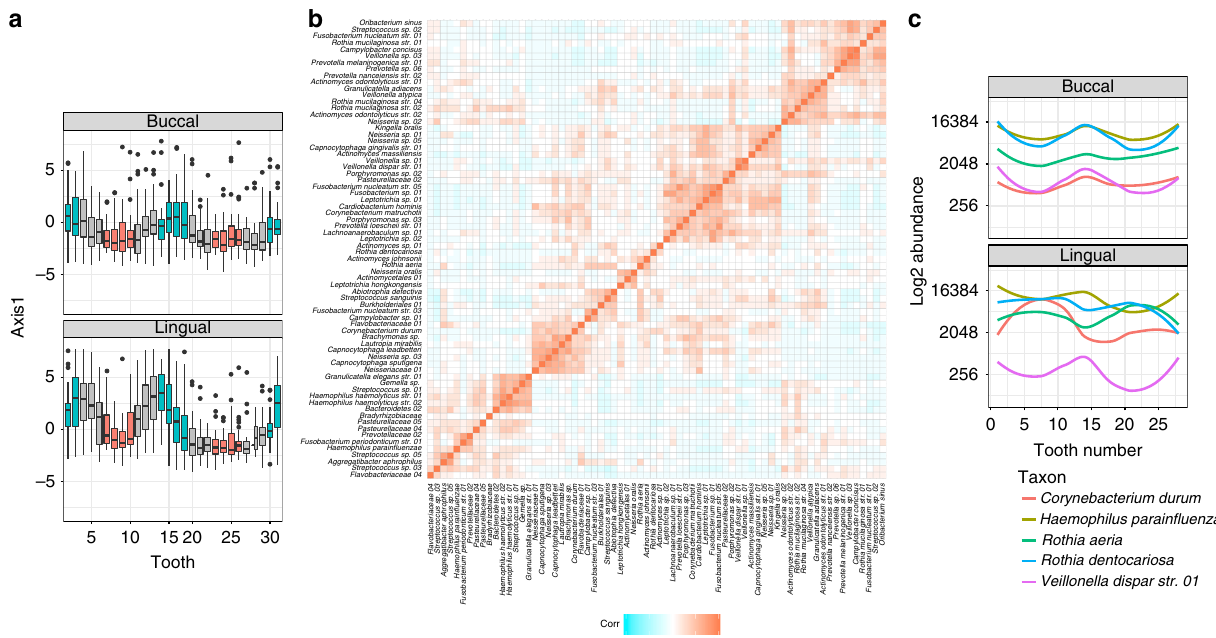
Fig. 2 Supragingival communities vary by tooth class in a structured fashion suggestive of a gradient. a Trend surface analysis (TSA) was performed on the species by sample data matrix (117 taxa, 1701 samples). TSA axis 1 scores ( y axis) are plotted as a function of universal tooth number ( x axis). Each box demarcates the fi rst and third quartiles of the TSA axis 1 scores, for each tooth, while the horizontal black lines within each box de fi ne the median TSA axis 1 scores. Boxes are colored according to tooth class (molars, incisors, other tooth classes) and samples from the lingual and buccal tooth aspects are shown separately. Molar communities (lingual N = 248; buccal N = 249) appeared to be associated with more positive scores along axis 1 compared to incisor communities (lingual N = 250, buccal N = 249) that shared more negative axis 1 scores. Of special interest, canine (lingual N = 125; buccal N = 126) and premolar (lingual N = 227; buccal N = 227) communities appeared to be arrayed in an ordered fashion in between the molar and incisor poles. b The between-taxa correlation matrix arranged by hierarchical clustering with average linkage revealed groups of taxa that shared positive or negative correlations in their distributions across samples and c exhibited a signi fi cant pattern of spatial dependence in their distributions across sites (Moran ’ s I , adj. p <